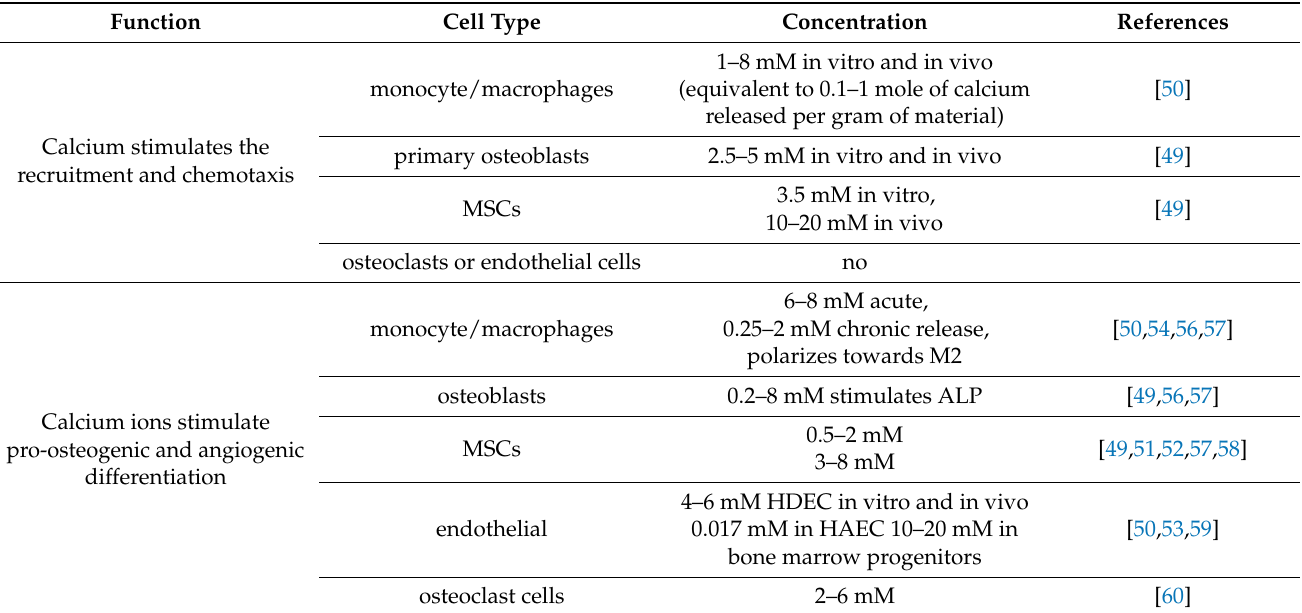
Table 4. Correlation of the calcium concentration and bone